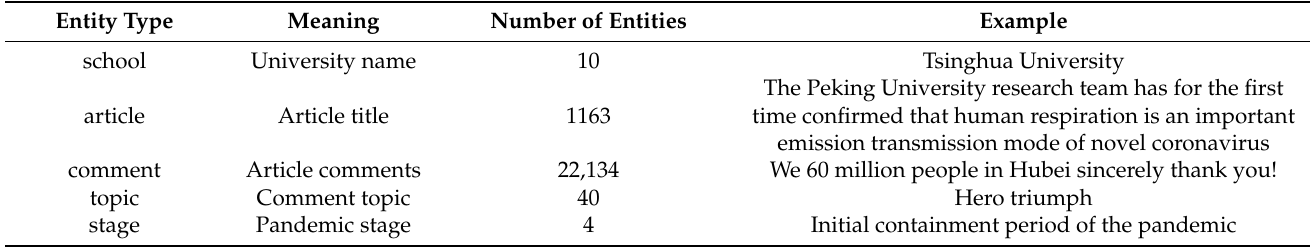
Table A2. Knowledge graph entity types.